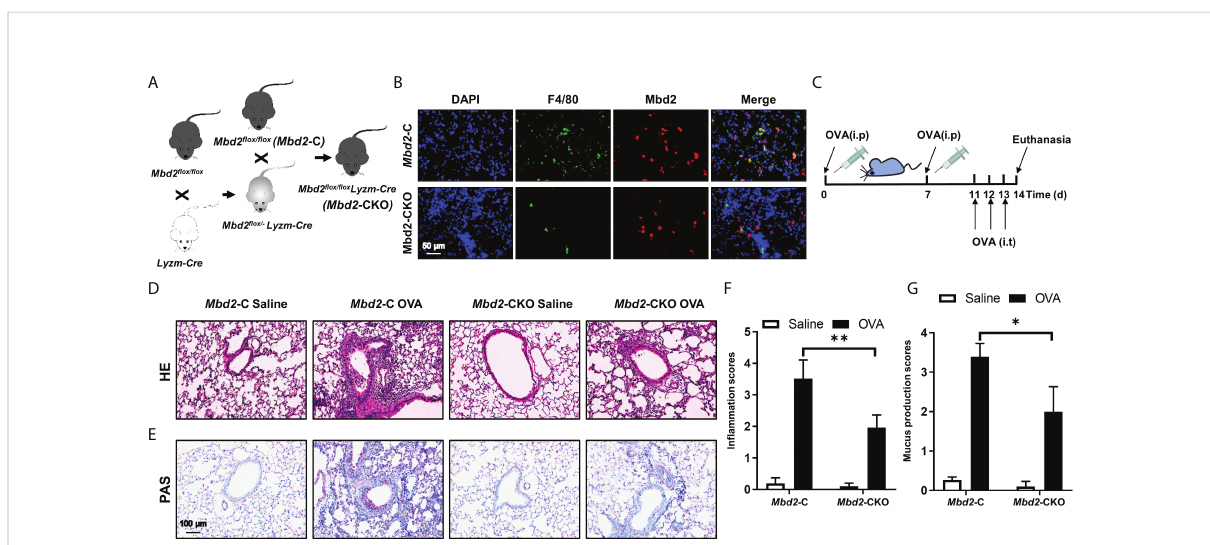
FIGURE 2 Comparison of the severity of lung in fl ammation between Mbd2 -CKO and Mbd2 -C mice after 3 days of OVA challenge. (A) : Macrophage- speci fi c Mbd2 knockout mice (named Mbd2 -CKO) were generated by crossing Mbd2 fl ox/ fl ox mice with LyzM-Cre transgenic mice. (B) : Representative coimmunostaining results of F4/80 and Mbd2 in lung sections from Mbd2 -C and Mbd2 -CKO mice. The nuclei were stained blue by DAPI, and the images were taken at an original magni fi cation of ×400. (C) : Schematic for the experimental design. (D) : HE staining for the analysis of lung in fl ammation. (E) : PAS staining for the analysis of mucus hypersecretion. (F – G) : Bar graphs represent the quantitative mean score of the severity of in fl ammation (F) and mucus production (G) . The images were taken at ×200 magni fi cation. The data were collected from 4-5 mice in each study group. *p < 0.05; **p < 0.01.